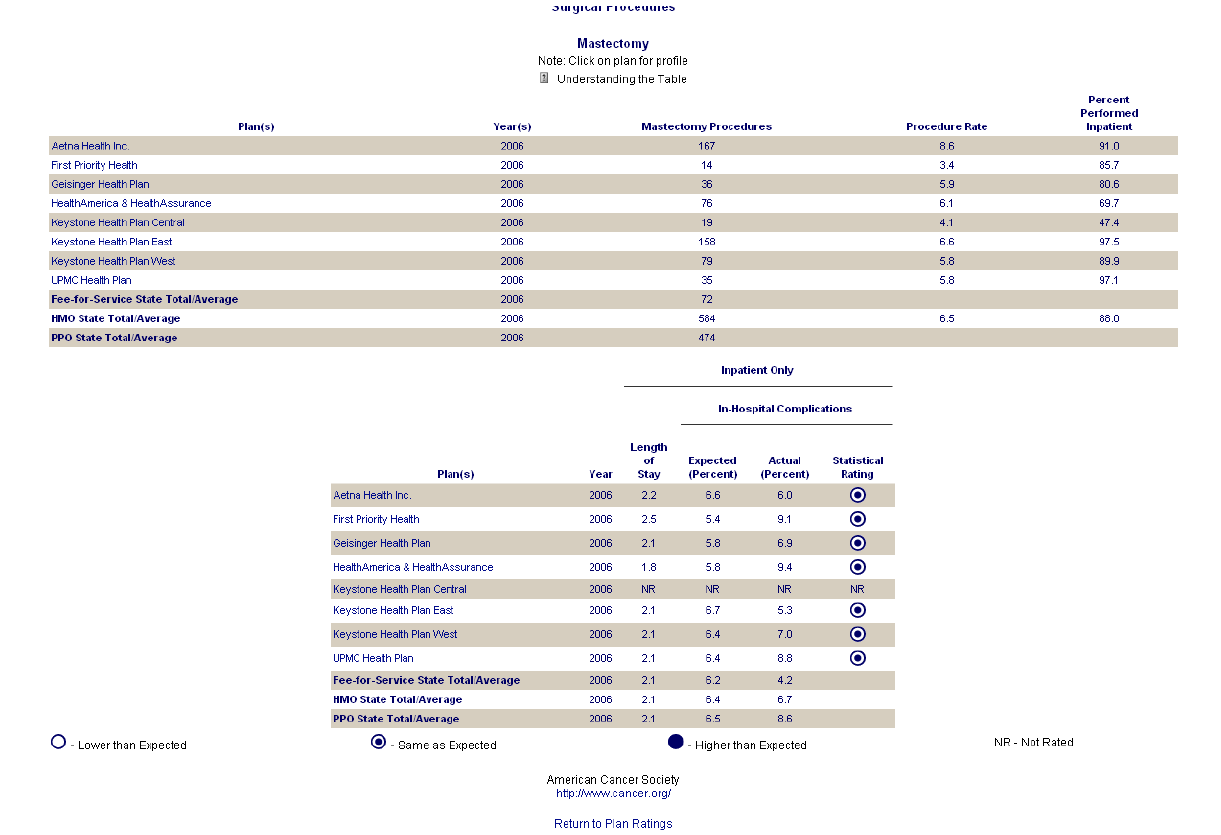
Figure 2. Example of type 0 integration (no integration of different types of comparative information)